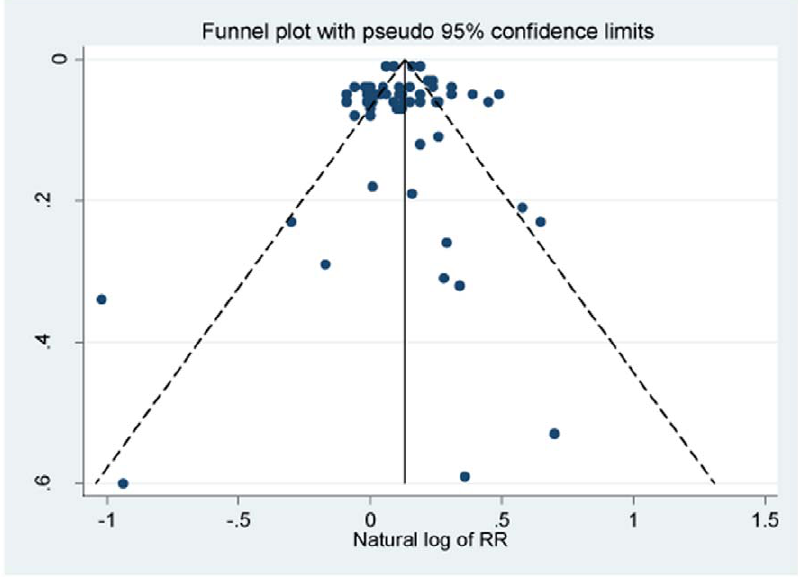
Figure 6. Funnel Plot of Reporting Bias.